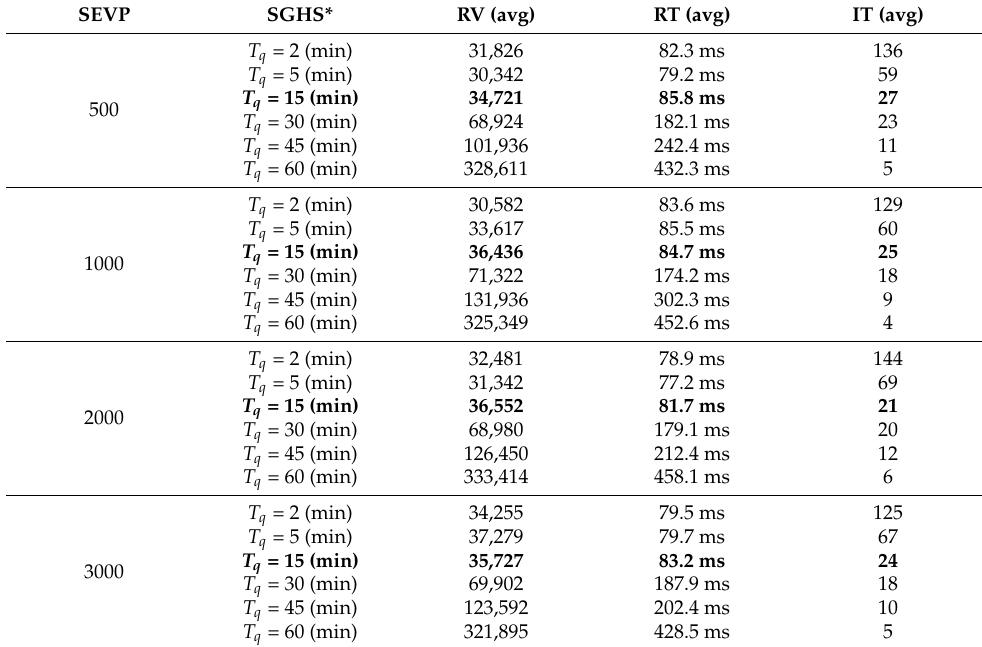
Table 5. Comparison with different query time